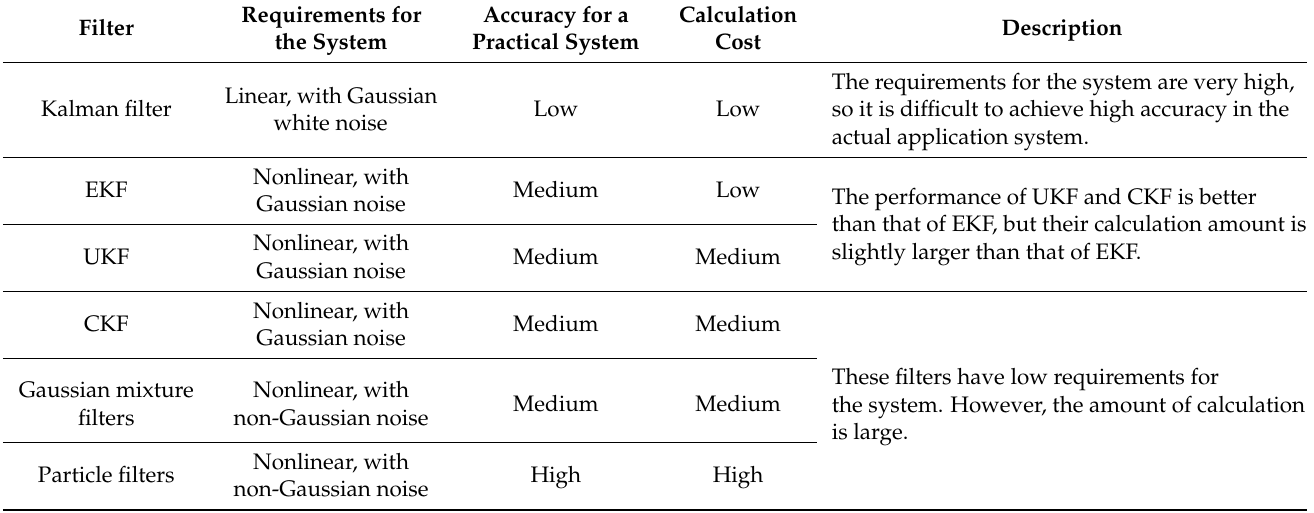
Table 1. Comparison of each